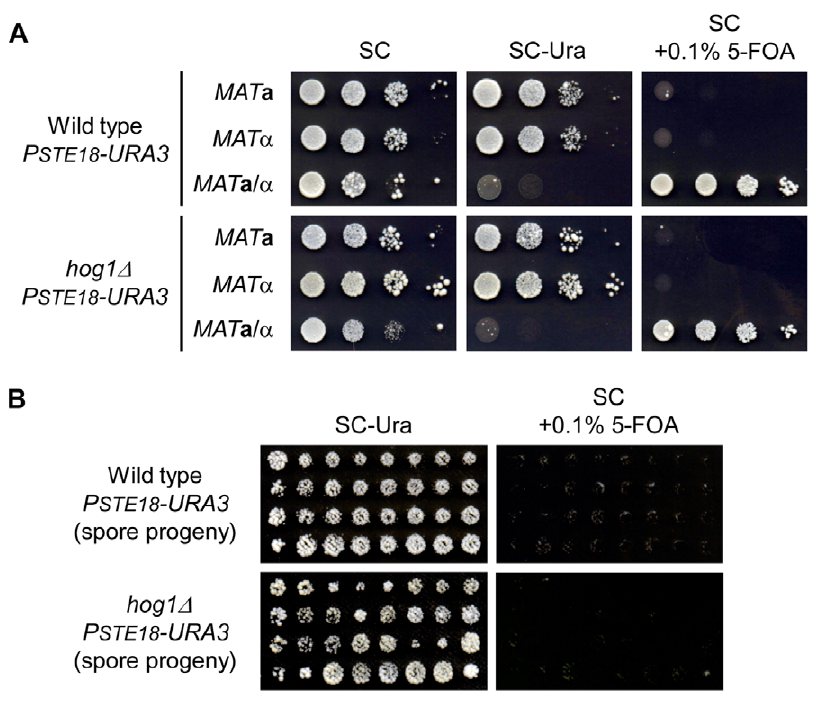
Figure 2. Effect of the PSTE18-URA3 gene on growth of haploids and diploids. (A) The haploid and diploid PSTE18-URA3 strains display opposite growth phenotypes on plates lacking uracil or containing 5-FOA. The strains were grown for 2–3 days at 30 u C. (B) The growth phenotype of the diploid PSTE18-URA3 strain can revert to that of haploid after sporulation. The indicated diploid strains were sporulated, tetrads were dissected and spore progeny was grown on YPD plate for 3 days at 30 u C. Then, the cells were replicated on the indicated plates and grown for 2–3 days at